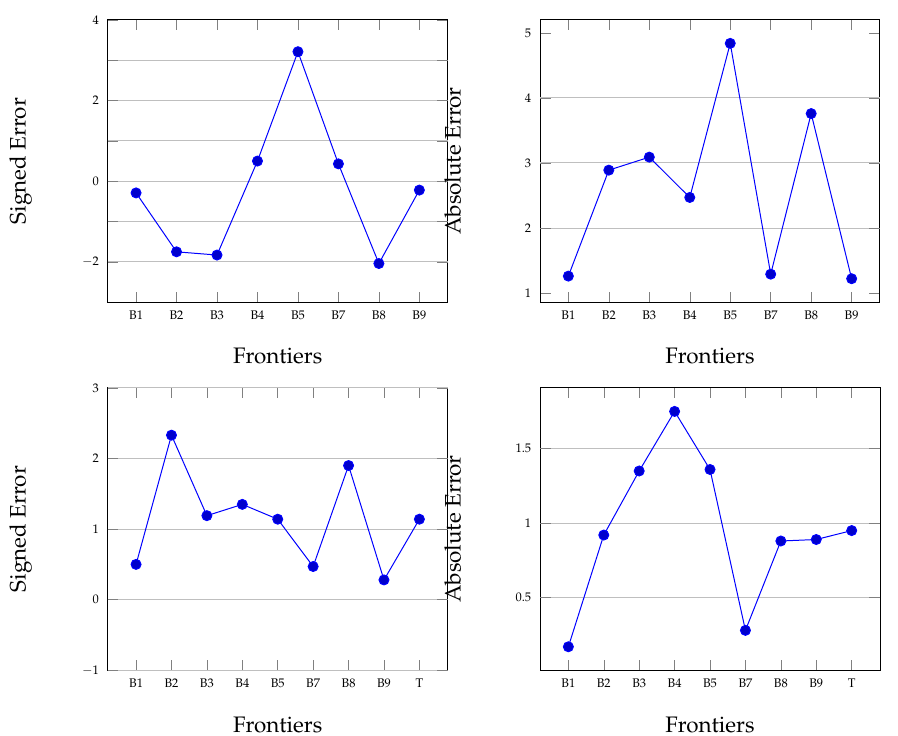
Figure 6. Mean ( top ) and standard deviations ( bottom ) for SE (signed error) and AE (absolute error) for healthy retinas.